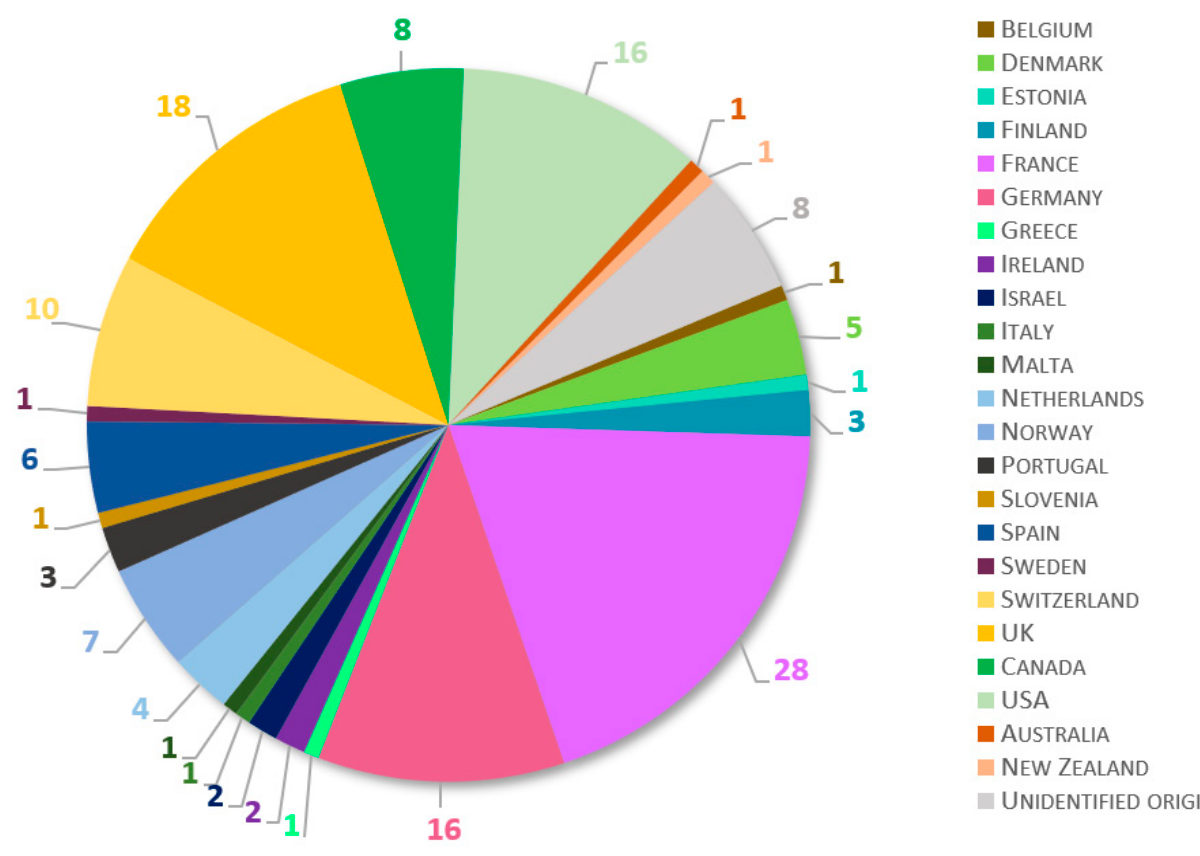
Figure 1. Geographical distribution of laboratories participating in the survey. Total number of contributing laboratories was 145. Eight participants did not declare the location of their facility (“Unidentified origin”).